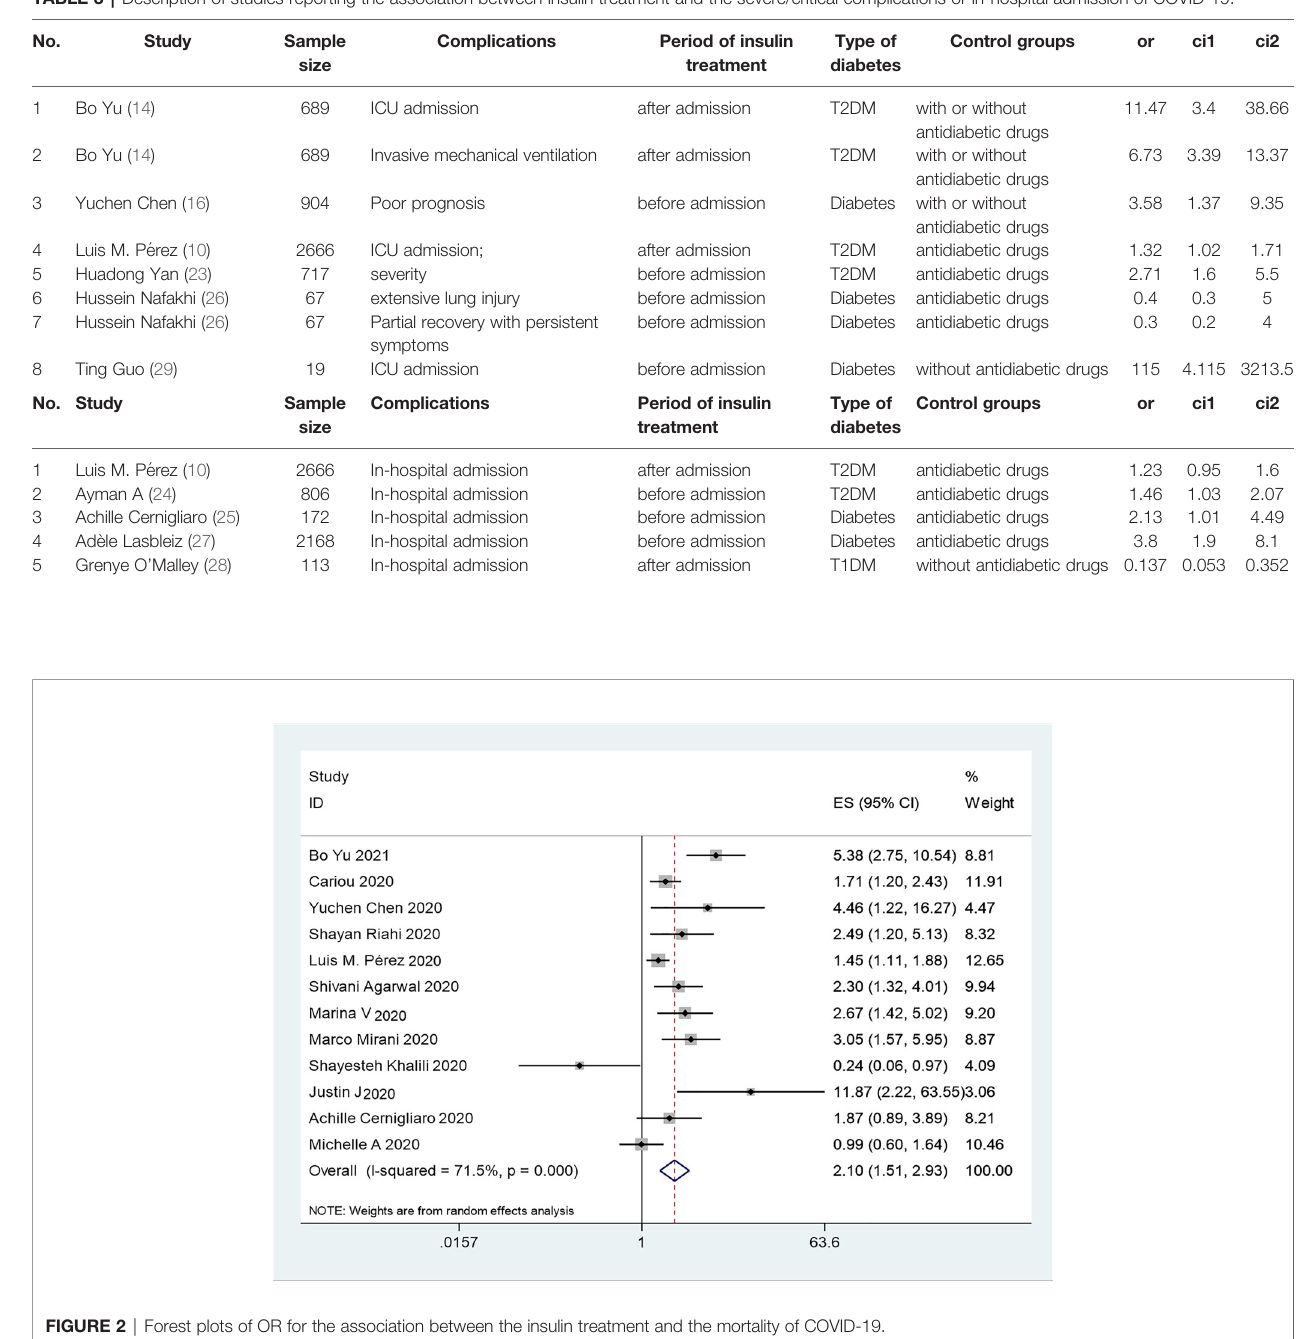
FIGURE 2 | Forest plots of OR for the association between the insulin treatment and the mortality of COVID-19.